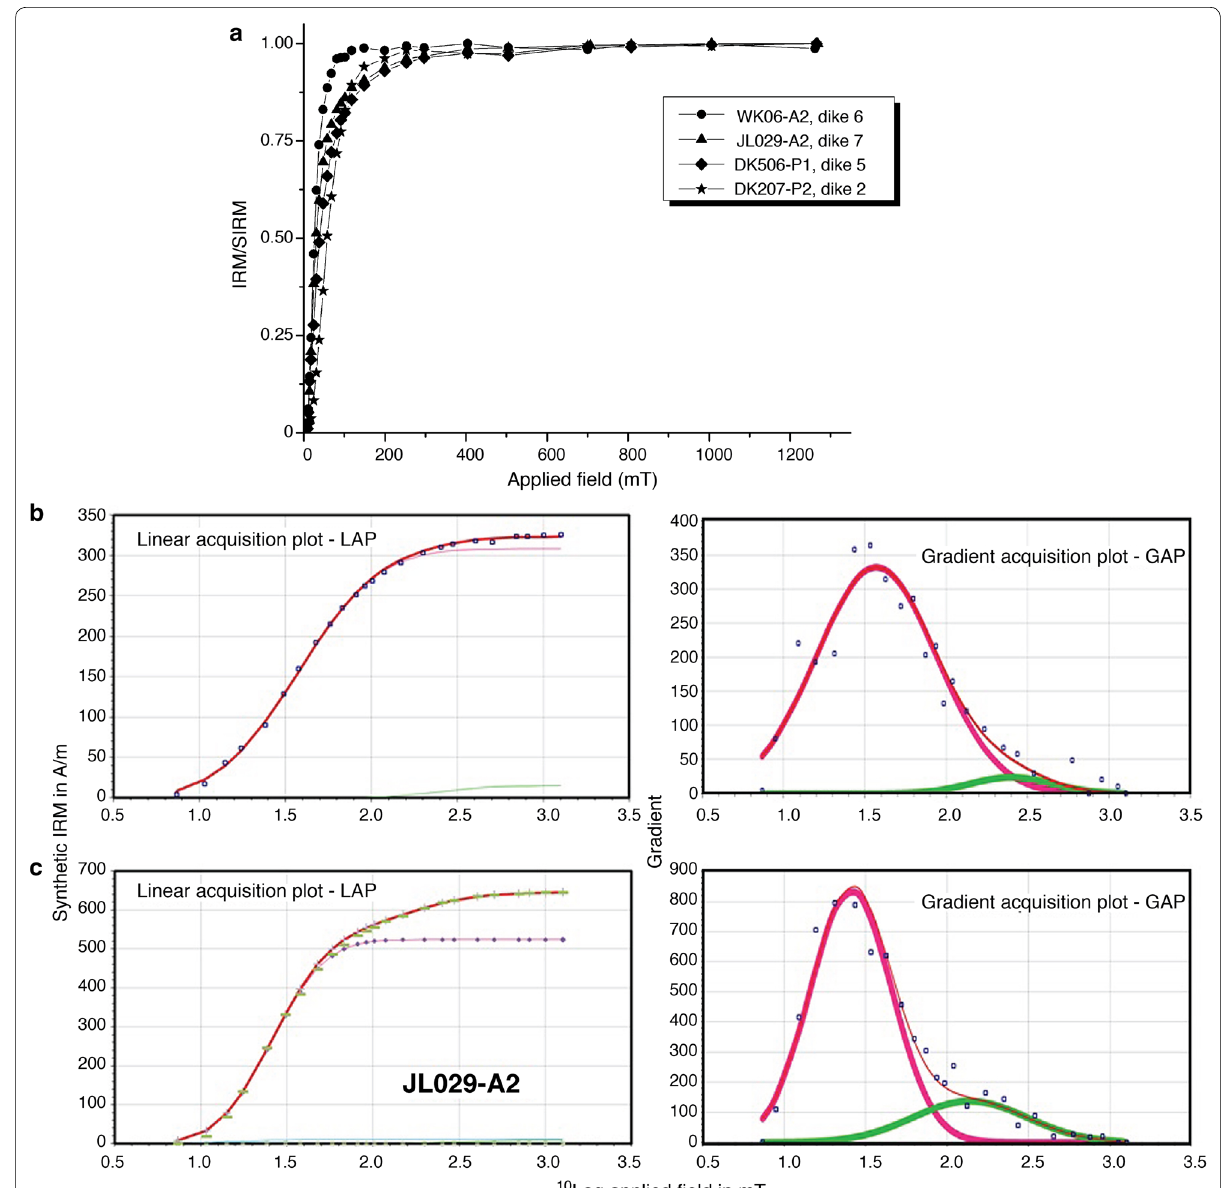
Fig. 4 IRM/SIRM acquisition curves. a Plot of IRM acquisition and backfield demagnetization curves (inset) for four representative samples, b , c linear acquisition plot (LAP) and gradient acquisition plot (GAP) for two representative